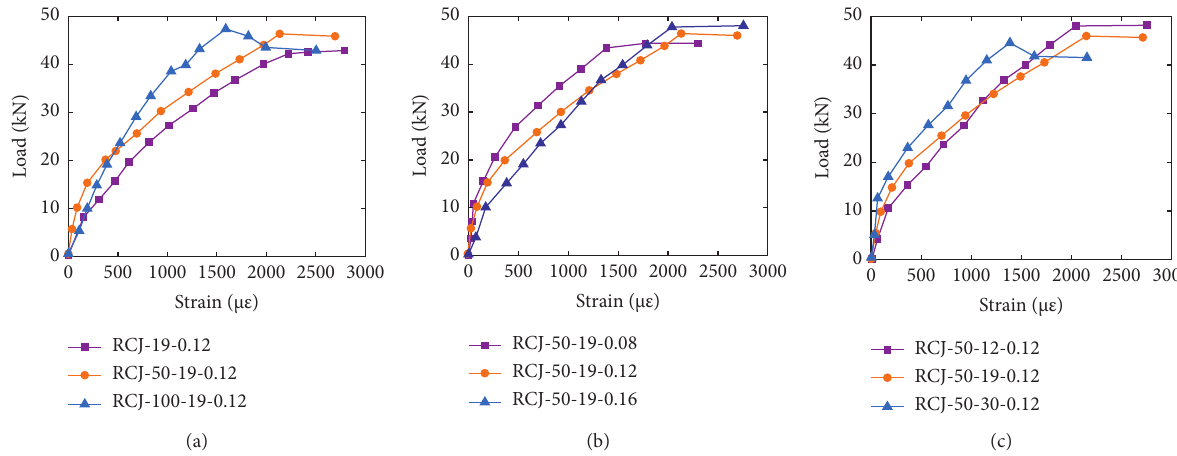
Figure 14: Comparison of influencing factors of strain-load curve of longitudinal reinforcement at beam end. (a) Replacement rate of RCA. (b) Volume of waste fibers. (c) Length of waste fibers.